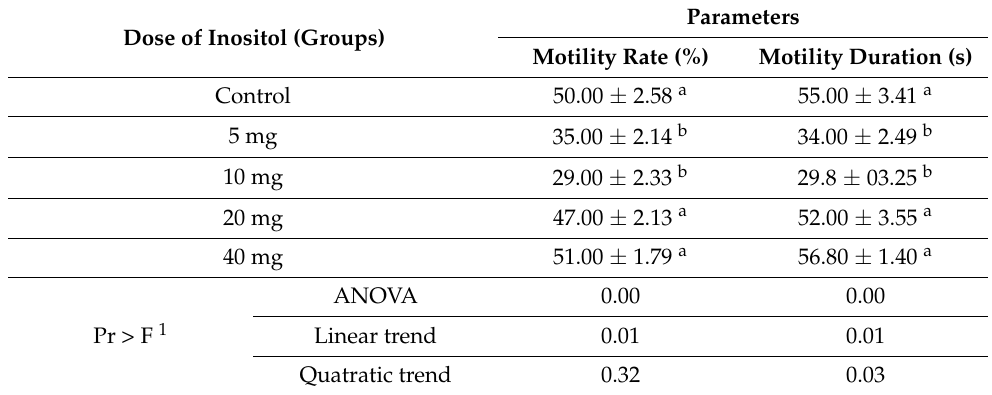
Table 1. Spermatological parameters of S. triostegus after thawing (mean ± SE, n = 7).